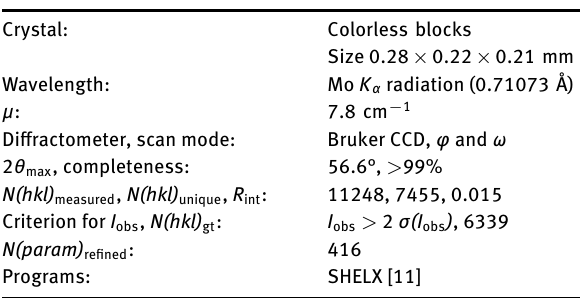
Table 1: Data collection and handling.